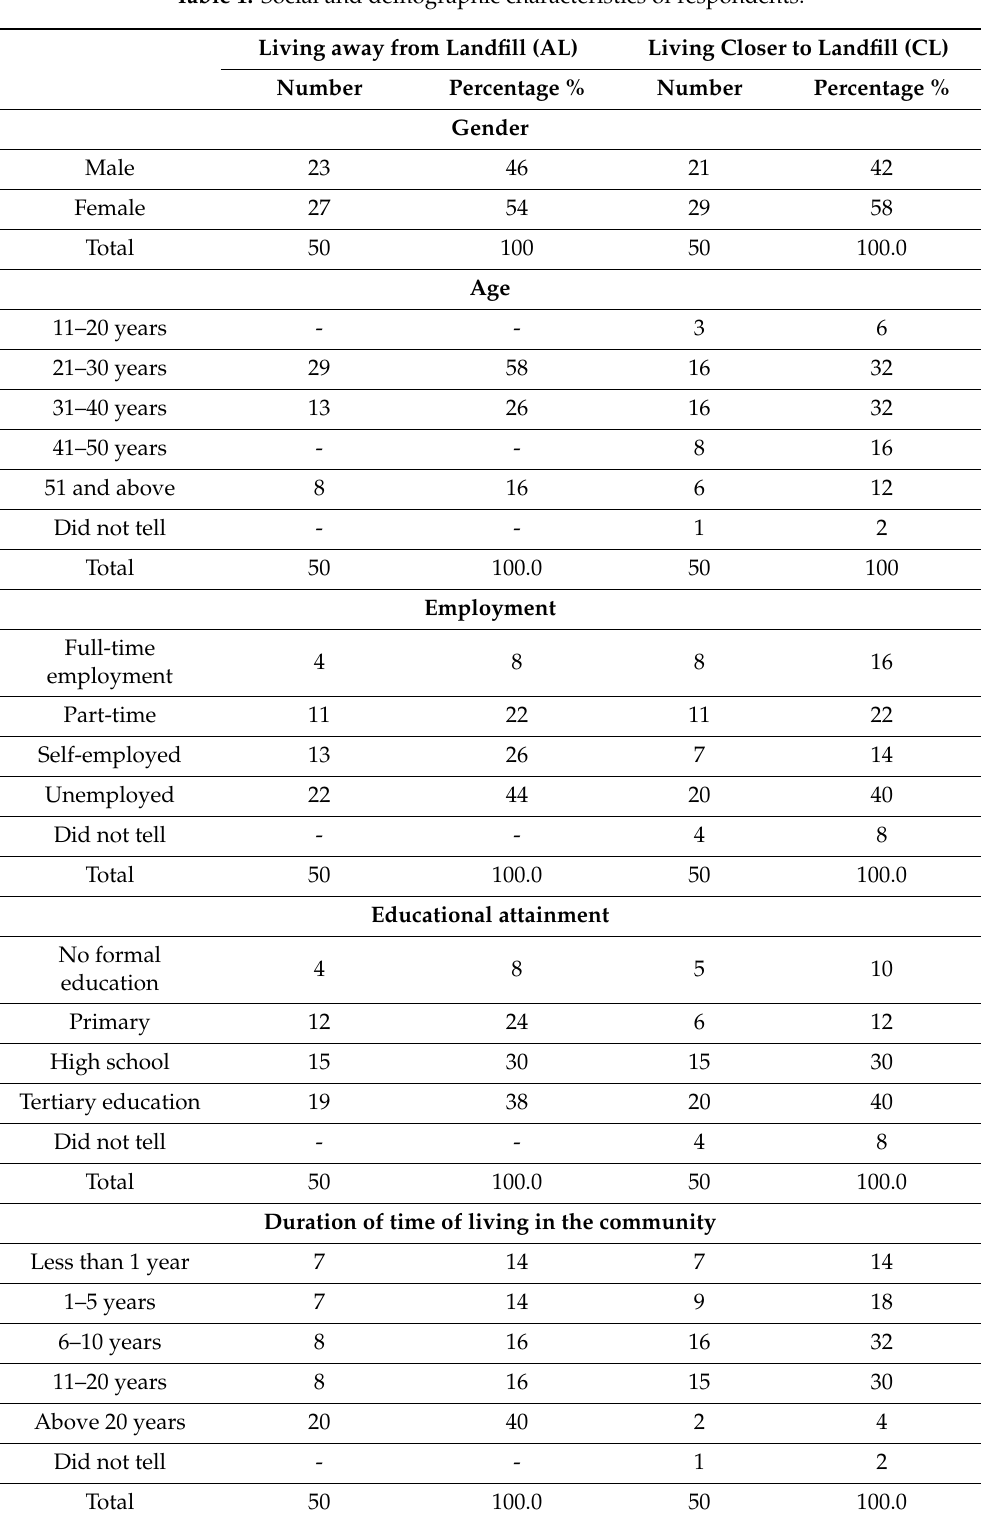
Table 1. Social and demographic characteristics of